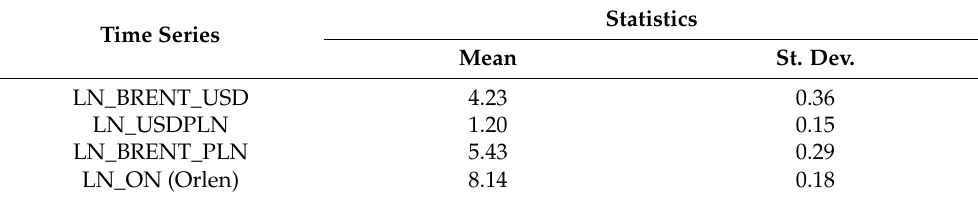
Table 2. Volatility of crude oil and diesel oil